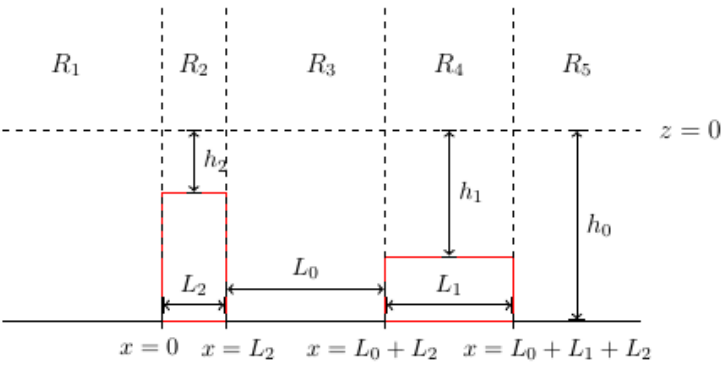
Figure 4. Diagram of a two-bar non-identical wave reflector.